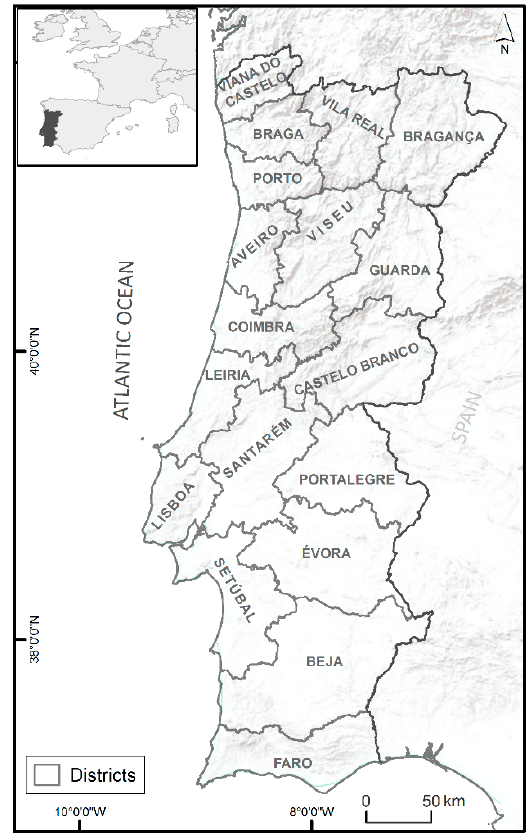
Figure 1. The study area (Portuguese districts).